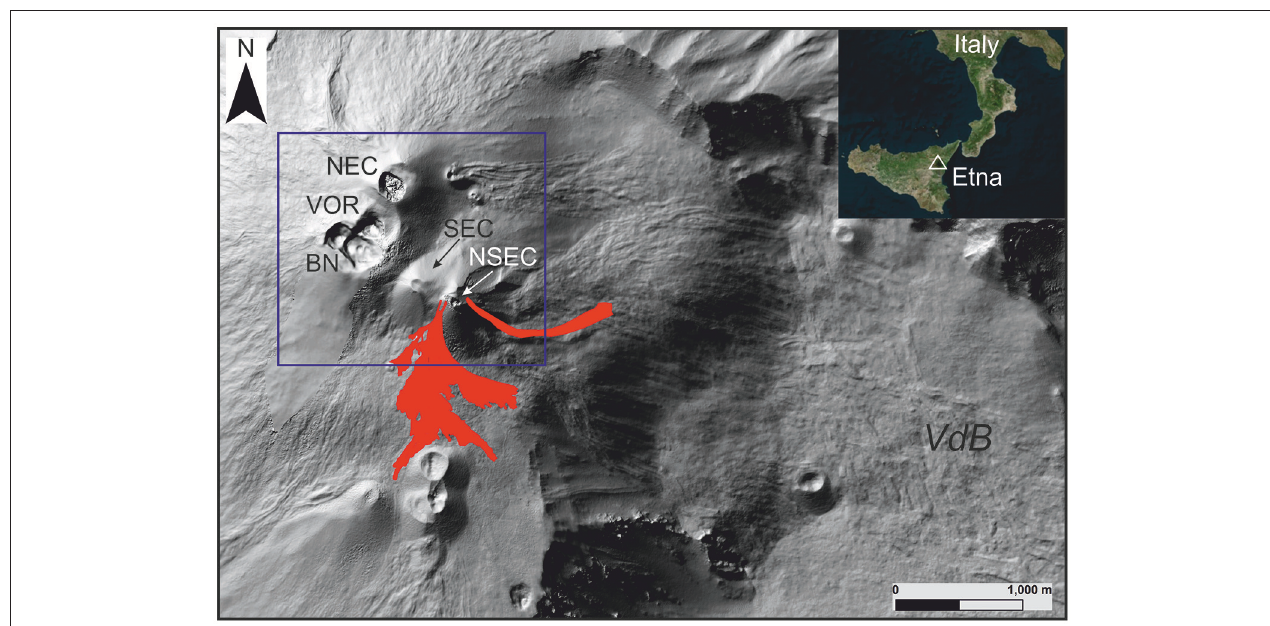
FIGURE 1 | Shaded relief of Mount Etna summit area. The blue square encloses the summit craters: NSEC, New South-East Crater; SEC, South-East Crater, BN, Bocca Nuova; VOR, Voragine; NEC, North-East Crater; VdB, Valle del Bove. Red polygons are the 25-26 October lava flows. Top right inset: map of southern Italy showing the location of